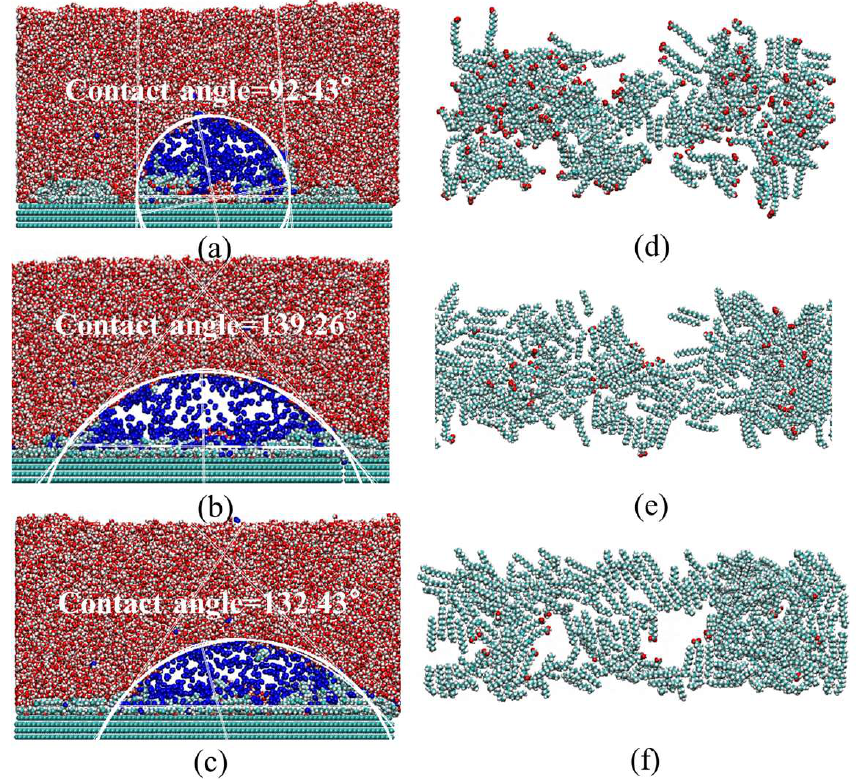
Figure 11. Adsorption configurations of bubbles on the surface of the oil film of the compound col- lectors ( a ) OA:DD = 3:1, ( b ) OA:DD = 1:3, and ( c ) OA:DD = 1:6. Top views of the oil film structures